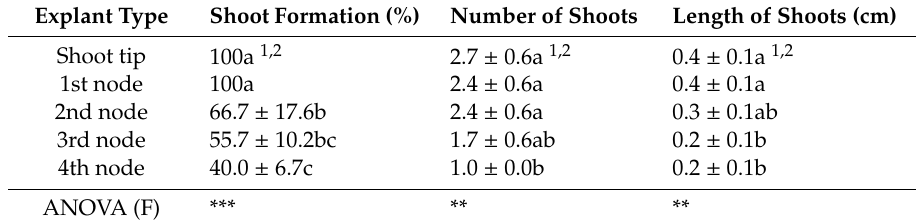
Table 1. Influence of type of explant on shoot formation frequency (%), number and length of shoots of V. dentatum cultured on solid MS nutrient medium with the addition of 5 µ M of 6-Benzylaminopurine